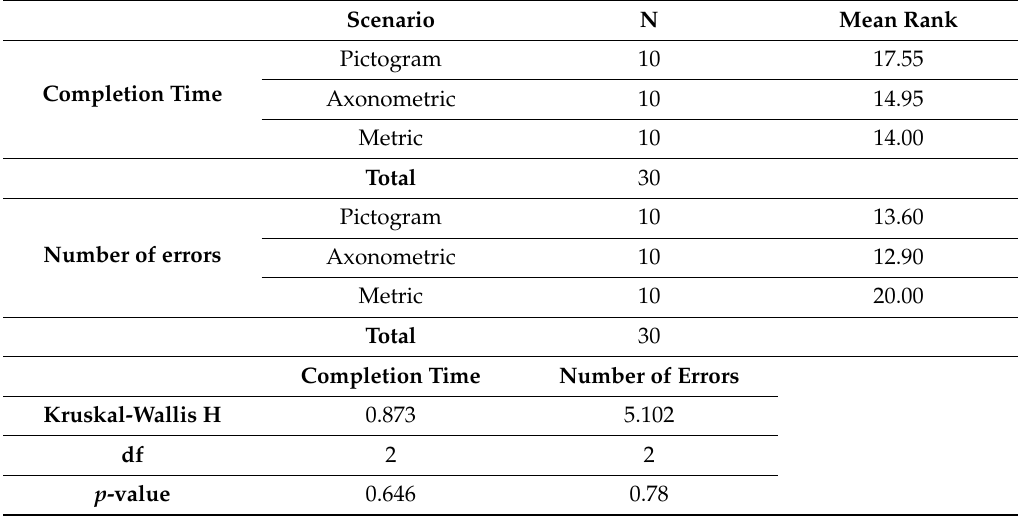
Table 7. Kruskal–Wallis H Test results of navigation task’s completion time and number of errors among three scenarios (1: Pictogram, 2: Axonometric, 3: Metric). Scenario N Mean